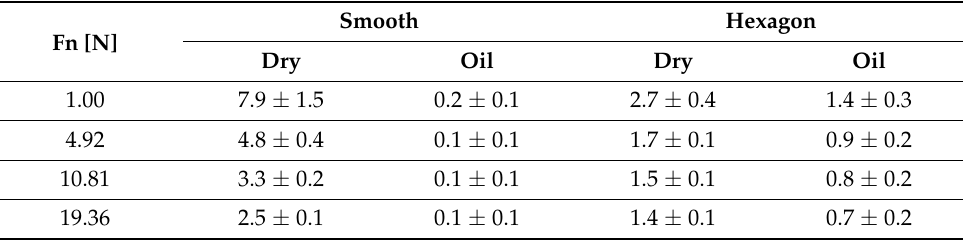
Table 1. Average friction coefficients with standard deviation of the smooth and hexagon GMFP on dry substrate and when completely submerged under mineral oil for all normal